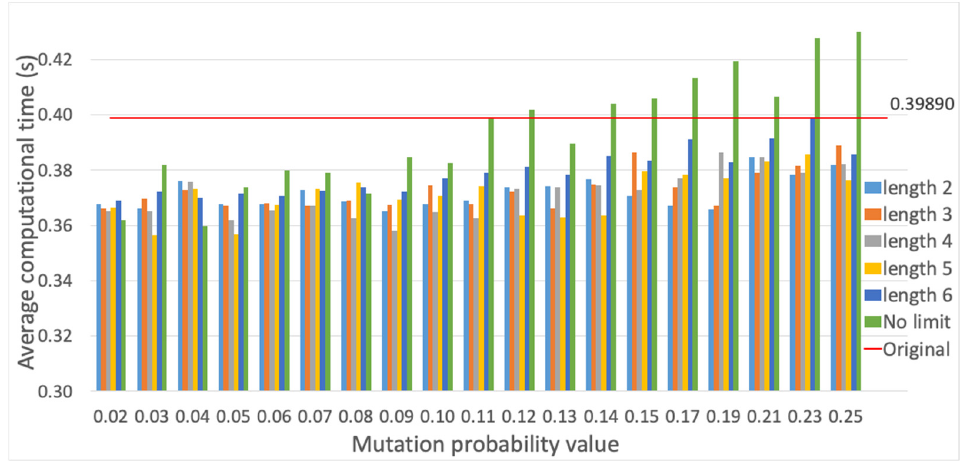
Figure 18. Average computational time (s) for SM method vs. different mutation probability values.